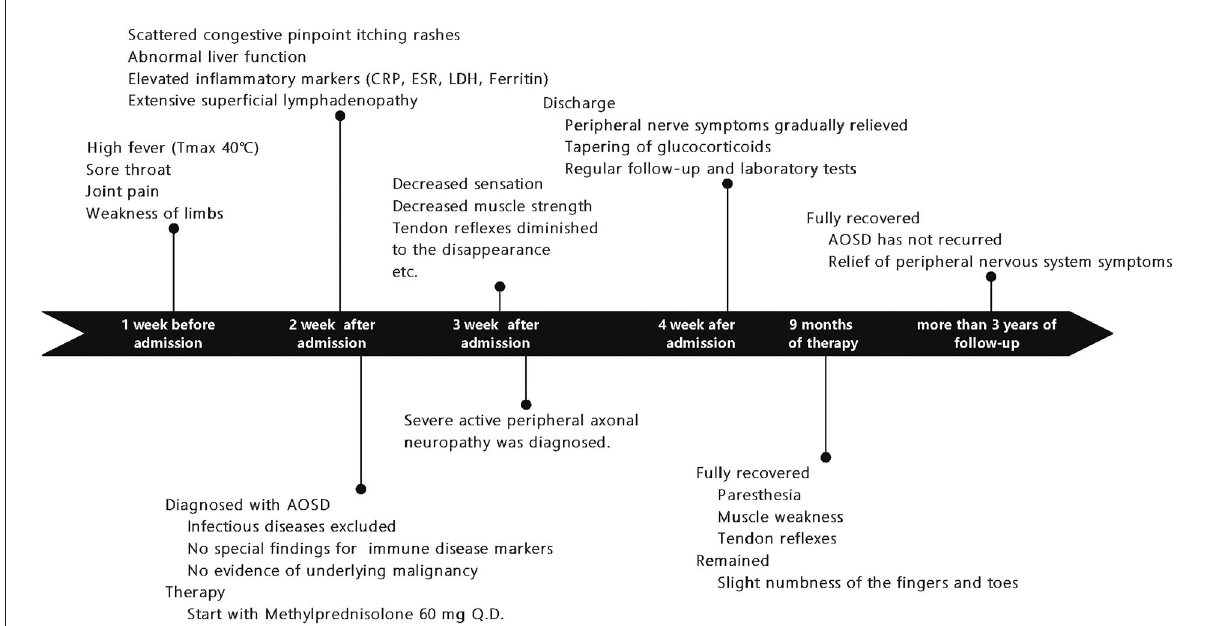
FIGURE1 A timeline showing symptoms and exams/interventions performed on the patient. AOSD, Adult-onset Still’s disease; CRP, C-reactive protein; LDH, lactate dehydrogenase, ESR, erythrocyte sedimentation